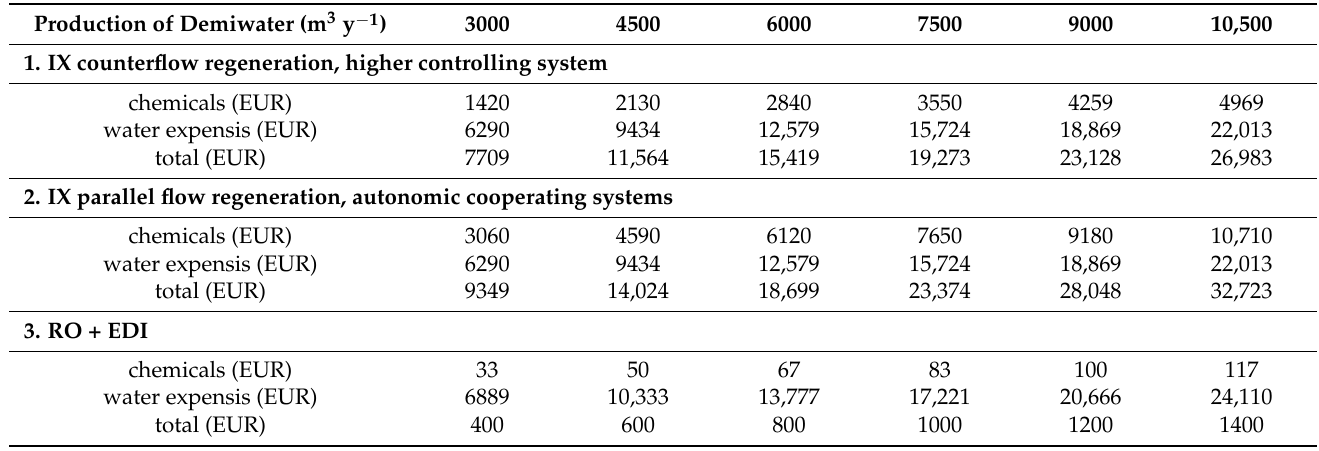
Table 4. OpEx of IX vs. RO + EDI (2010).